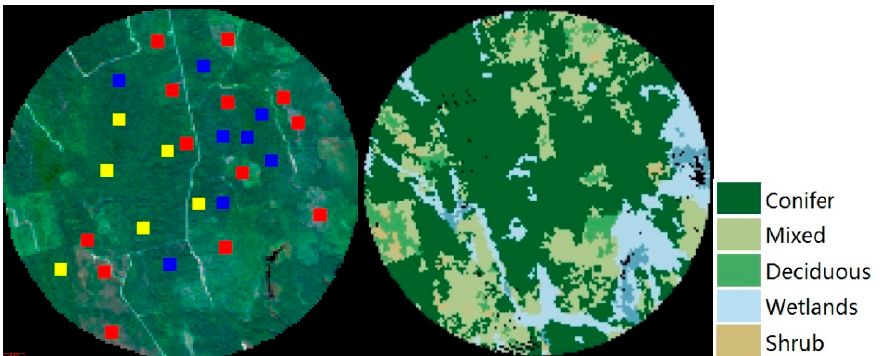
Figure 1. True color image of the nadir viewing AirMISR data collected in July 2003 ( left ) and the typical forest type used in this study ( right ). Three kinds of stands with a size of 5 × 5 pixels: the red, blue, and yellow squares represent low forest stands, high and sparse forest stands, and high and dense forest stands, respectively.